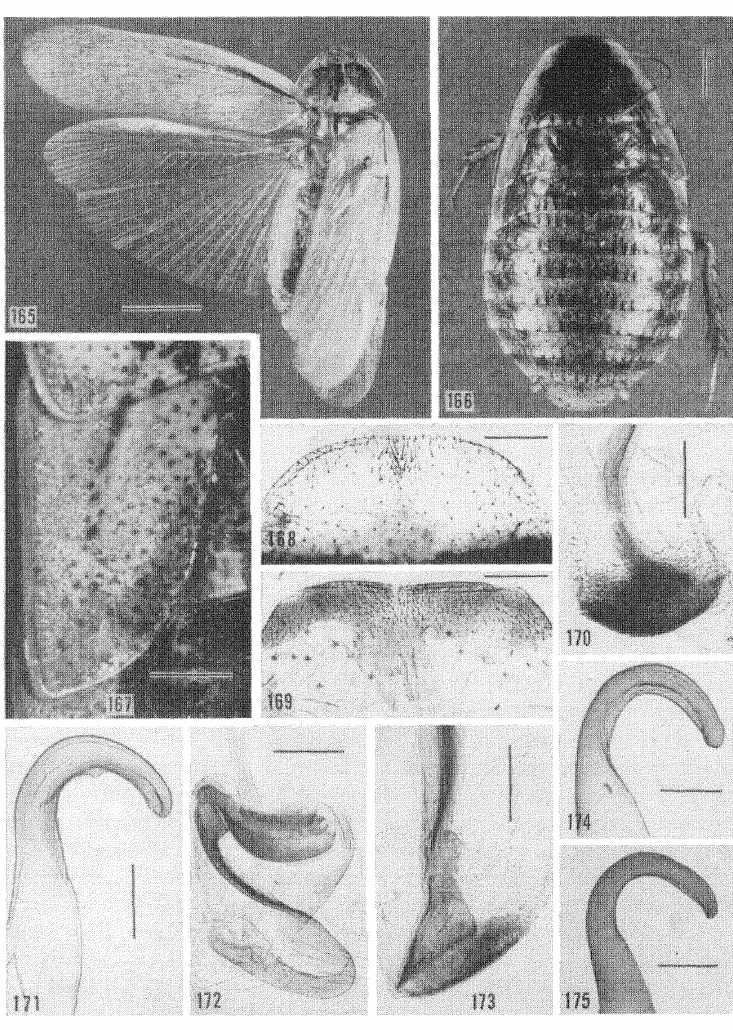
Figures 165-175. Calolamkra mjoebergi. 165. 6 (296 L in SM), holo- type, Colosseum, Q. 166. (143 M.CZ), para.type, Ravenshoe, Atherton Tab., Q. 167. Tegmen o.f shown in figure 166. 168-172. Supra-anal plate, hypandrium, and genitalia of holotype shown in figure 165. 173- 174. / (297 L), Malanda, Q. Genitalia. 175. (105 MCZ), paratype, Ravenshoe, Atherton Tab., Q. R2 o genitalia. Scale: Fig. 165 mm; Fig. 166 ram; Fig. 167 mm; Figs. 168-169 0.5 ram; Figs. 170- 175 0.2